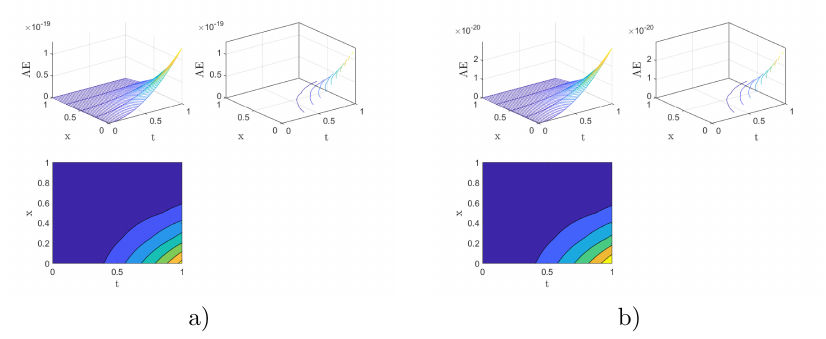
Figure 6. The AE functions of applying the proposed method with M = M ′ = 32, η = η 1 = 1 ( a ) and M = M ′ = 64 and η = η 1 = 1 2 Graphs of absolute error with m = m ′ = 1 and η = η 1 = 1 values of M = M ′ are depicted in Figure 7. Plots of the approximate solution behavior and exact solution of this example at t = 0 . 5 with m = m ′ = 1 and η = η 1 = 1 for different values of M and M ′ are illustrated in Figure 2